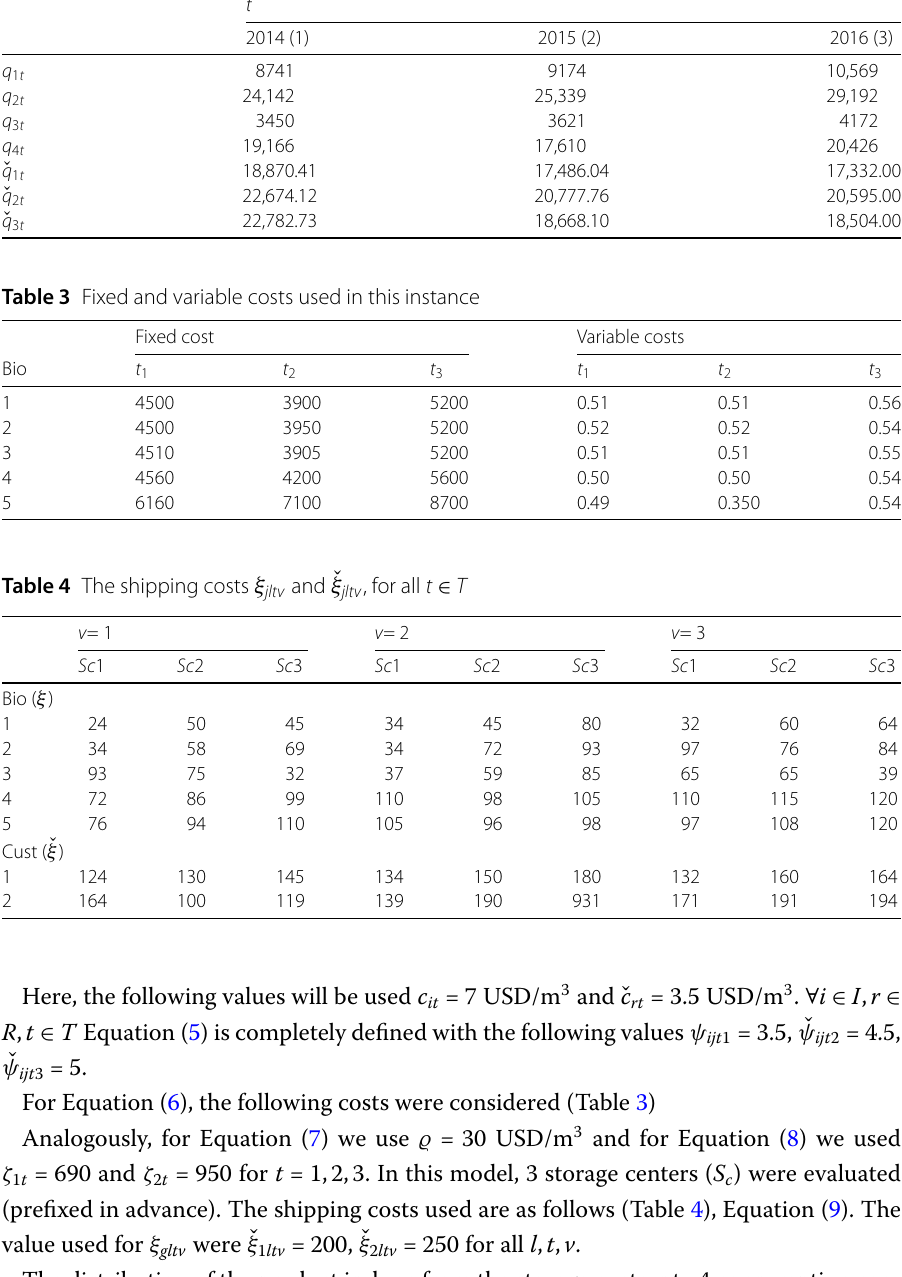
Table 2 Amounts of bagasse collected per year of planning